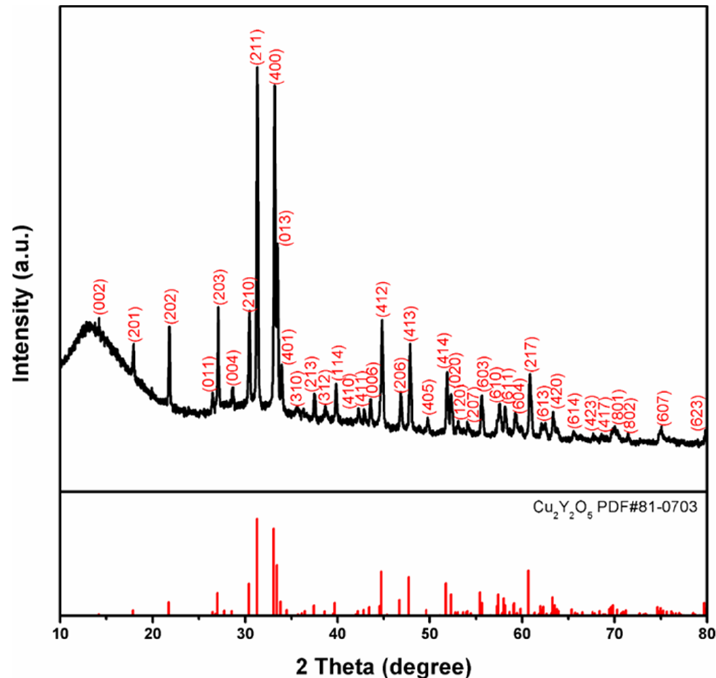
Figure 2. XRD pattern of Cu 2 Y 2 O 5 nanofibers.